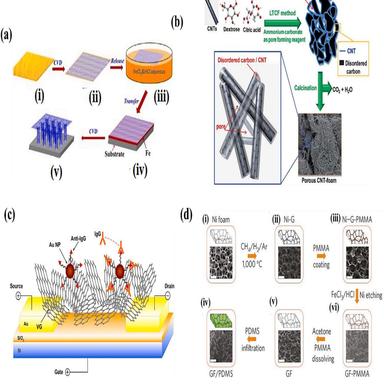
(a) Illustration of the two-step CVD technique used to create 3D CNT/graphene hybrid materials. Cu foil (i). CVD technique produced graphene on Cu foil. (iii) Graphene was released when Cu foil was dissolved in a FeCl3/HCl solution. (iv) Transfer of graphene to the substrate for the development of VACNT arrays. (v) materials made from a second CVD procedure that combine CNT and graphene; Reproduced with permission, (b) Preparation of porous CNT-foam composites via low temperature chemical fusi